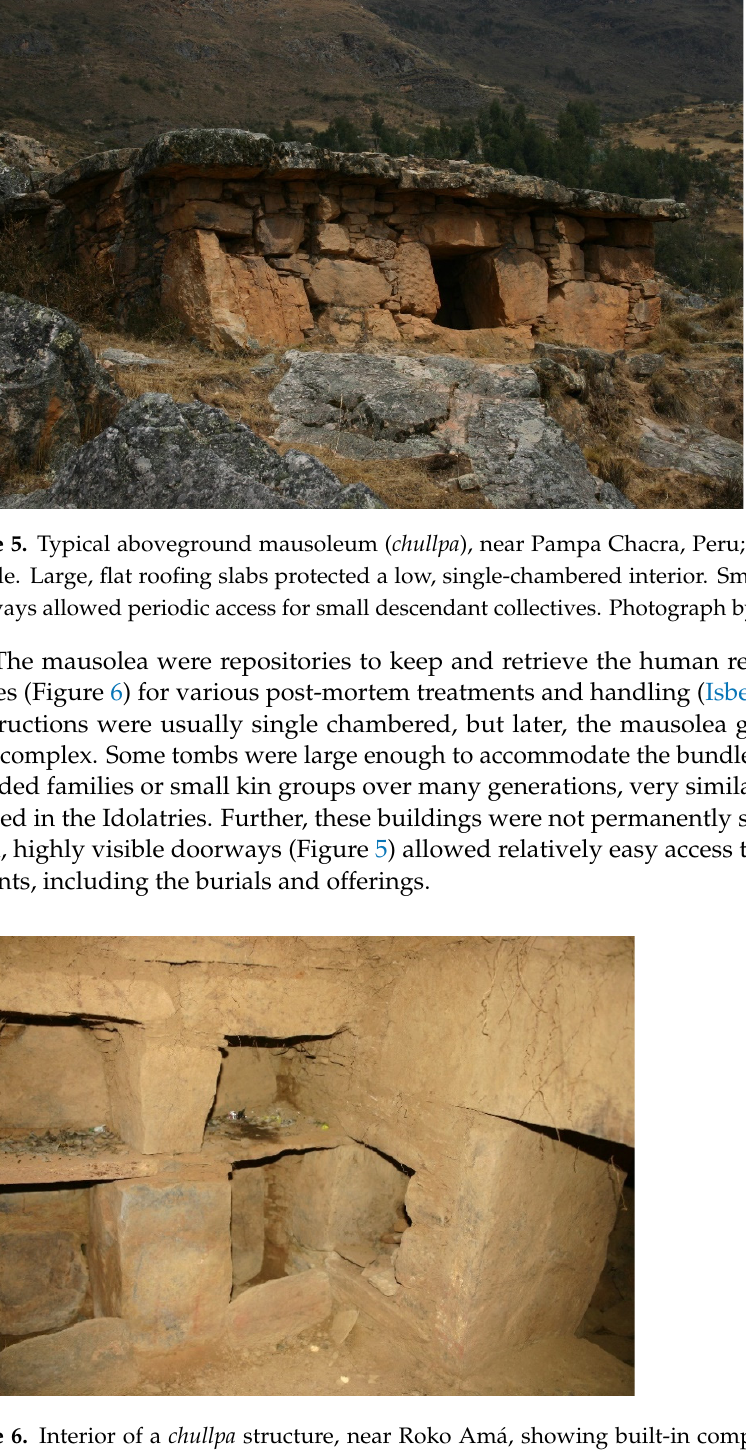
Figure 7. Photograph of Chinchawas, showing the main settlement mound and locations of a cere- monial enclosure (perhaps a ‘ cayan’ ) and a standing upright ( huanca ). Over 40 carved stone mono- liths were identified across the site. Photograph by author. Early colonial religiosity of the rural Andean highlands centered on entreating an- cestors for group wellbeing and renewal (Doyle 1988; Duviols 1971; Salomon 1995). The various tombs and ancestor images (see below) were instrumental because they